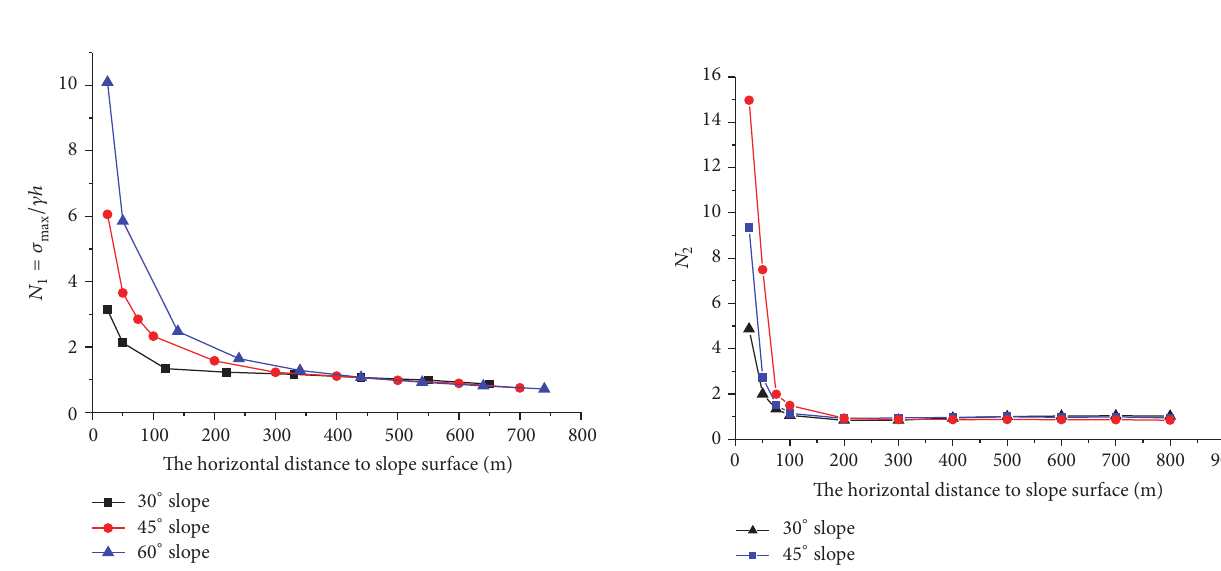
Figure 6: Variation curves of 𝑁 1 at the elevation of 0m in different slope angles when the lateral pressure coefficient is equal to 1.5.